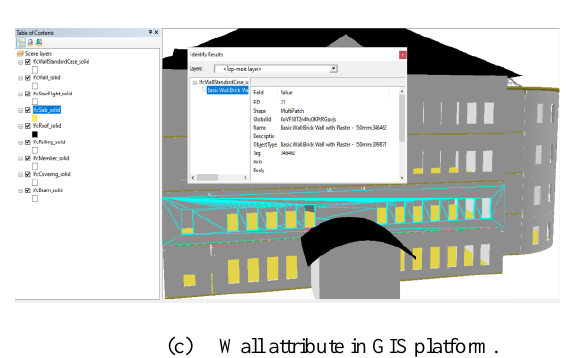
Figure 11. Validation on part of data semantic missing during conversion process from BIM into IFC.